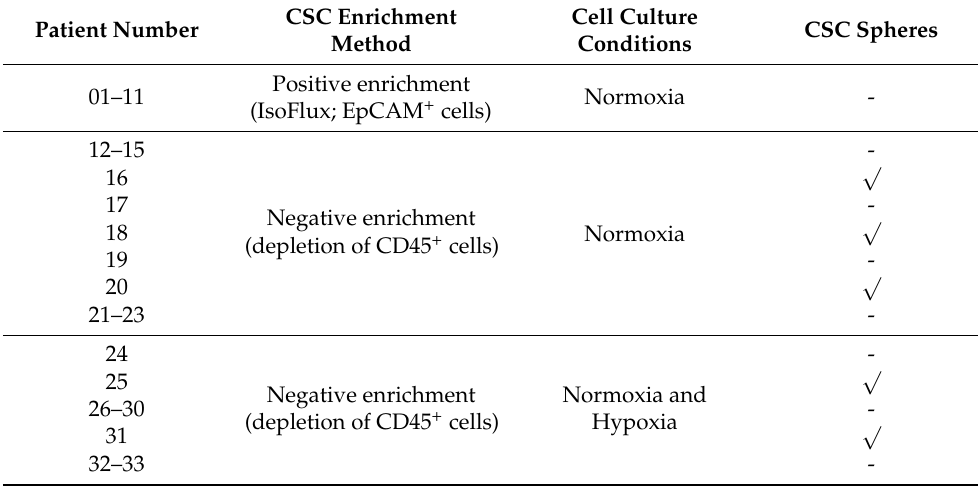
Table 6. Results of ex vivo culture of CTC spheroids from HCC patients undergoing TACE. The table shows the cell enrichment strategy, the cell culture conditions, and the presence of cellular spheres. CSC Enrichment Cell Culture Patient Number CSC Spheres Method Conditions Positive enrichment 01–11 Normoxia - (IsoFlux; EpCAM + cells)